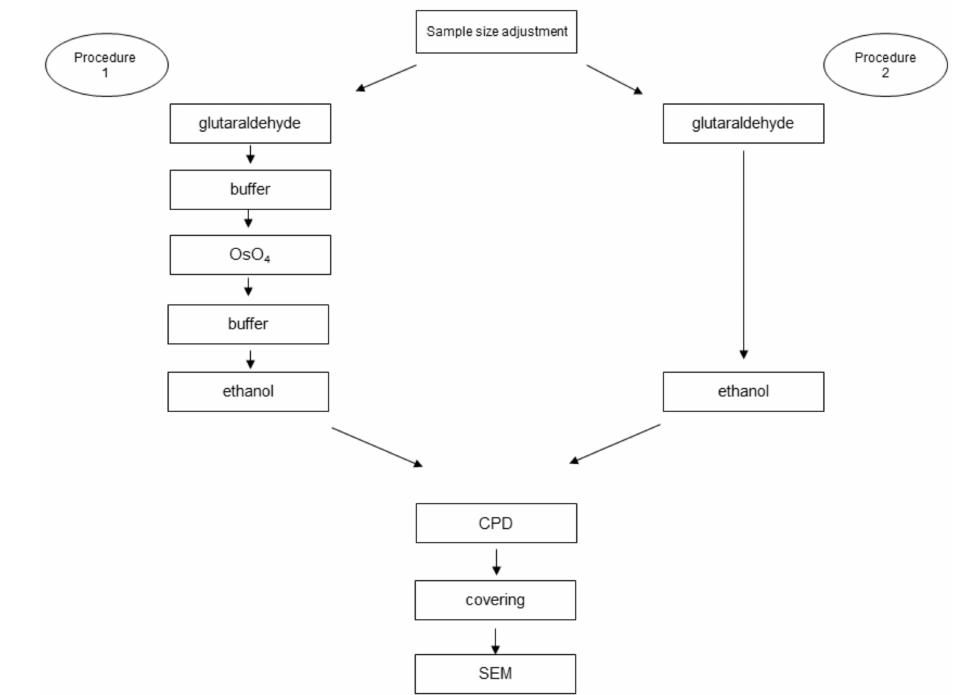
Figure 1. Graphic visualization of the provided